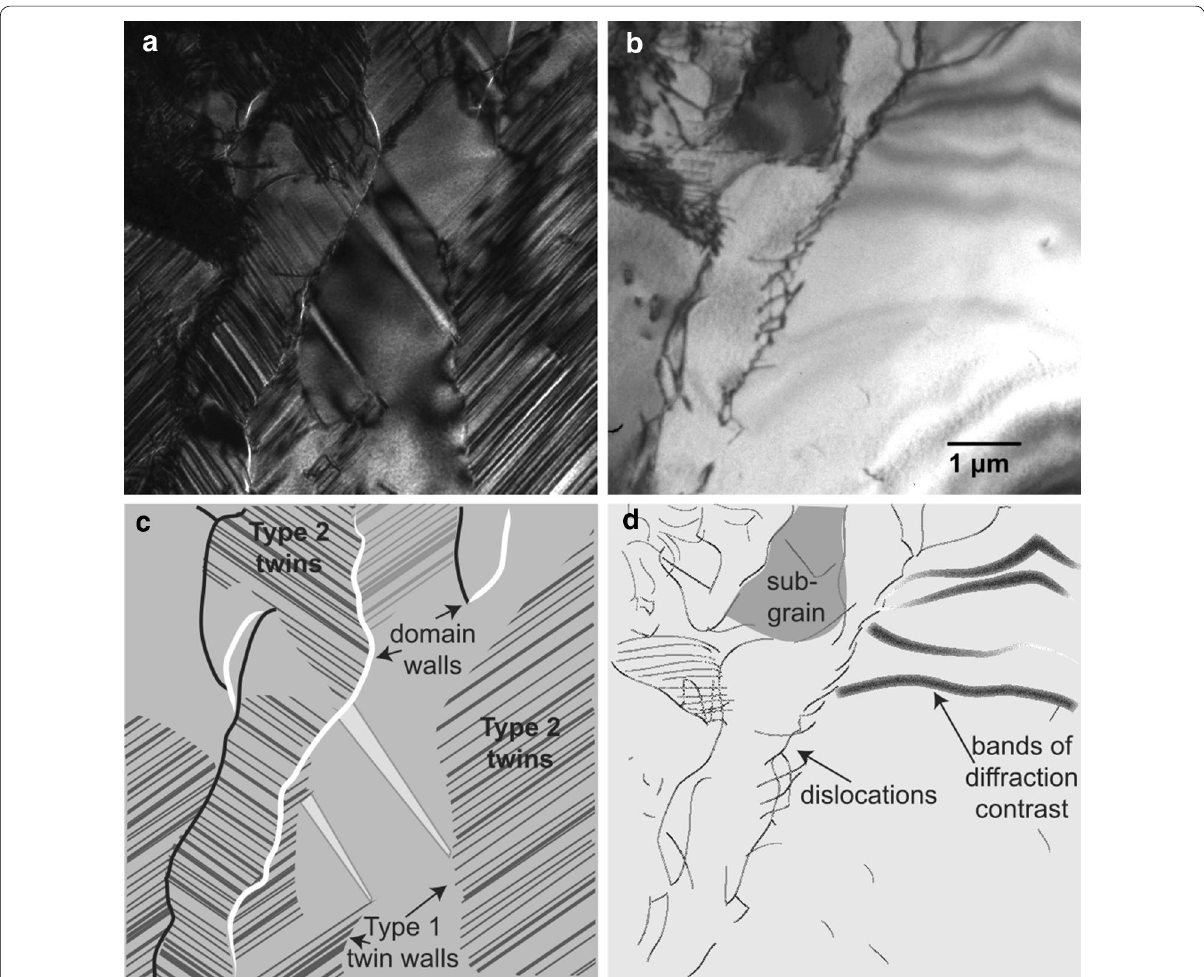
Fig. 1 TEM images showing domain walls, dislocations, and twin structures below the Verwey transition. All four images show the same region. a Dislocation-rich region below the Verwey transition. b Dislocation-rich region above the Verwey transition to illustrate the relationship between twin boundaries and dislocations. c Illustration describing image a . d Illustration describing image